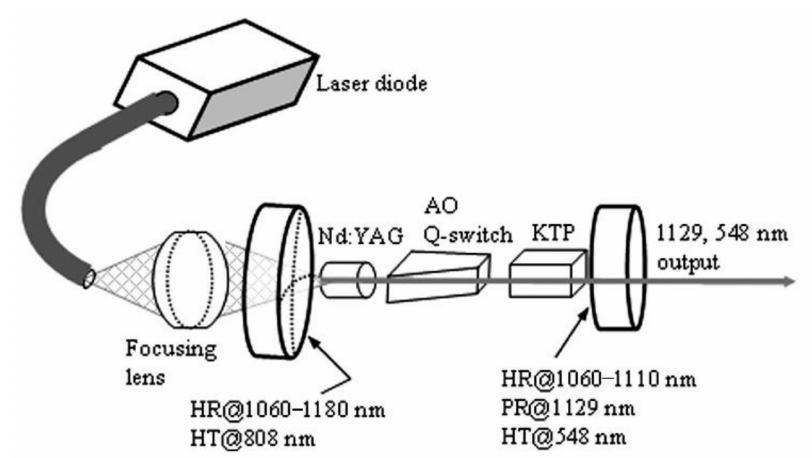
Figure 9. Schematic diagram of the KTP self-frequency-doubled Raman laser [114]: AO, acousto-optic; PR, partial reflection; HT, high transmission; HR, high reflection.